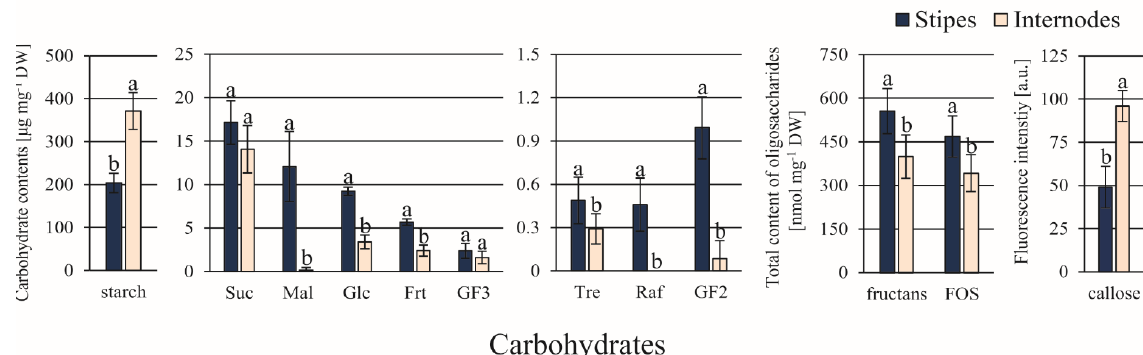
Figure 3. Production of ethylene by the C. delgadii stipe and internode explants at 1, 4, and 6 h after sample dissection. The production was stabilized between 4 and 6 h after explant excision. Therefore, the results obtained after 6 h were used for further analyses. Values represent the means ± standard deviation (SD) of 6 independent replicates. The Student’s t -test was used to estimate statistical significance of results. Data followed by different letters (a, b) were significantly different at p < 0.05.